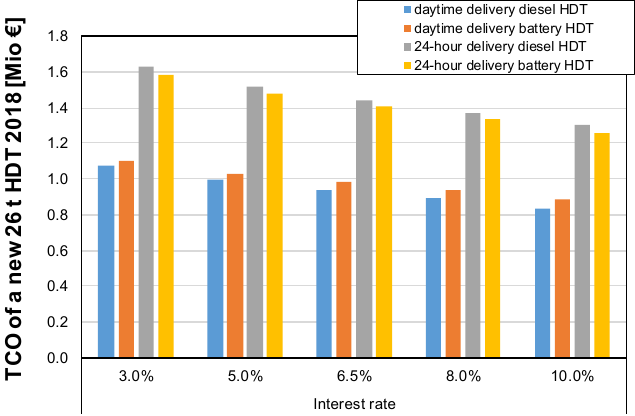
Figure 6. Sensitivity analysis for the absolute TCO of a new 26t truck in 2018 for different interest rates.